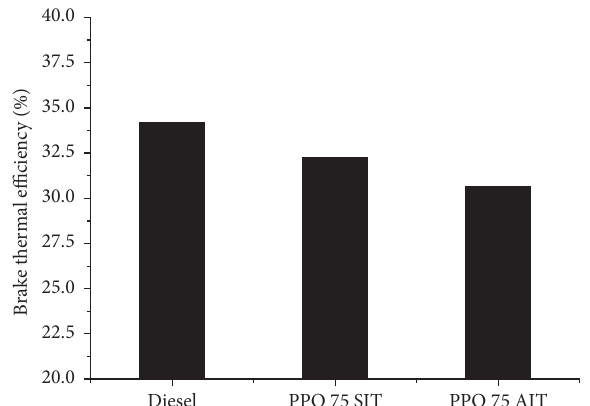
Figure 5: Brake thermal efficiency for diesel, PPO 75 SIT, and PPO 75 AIT.